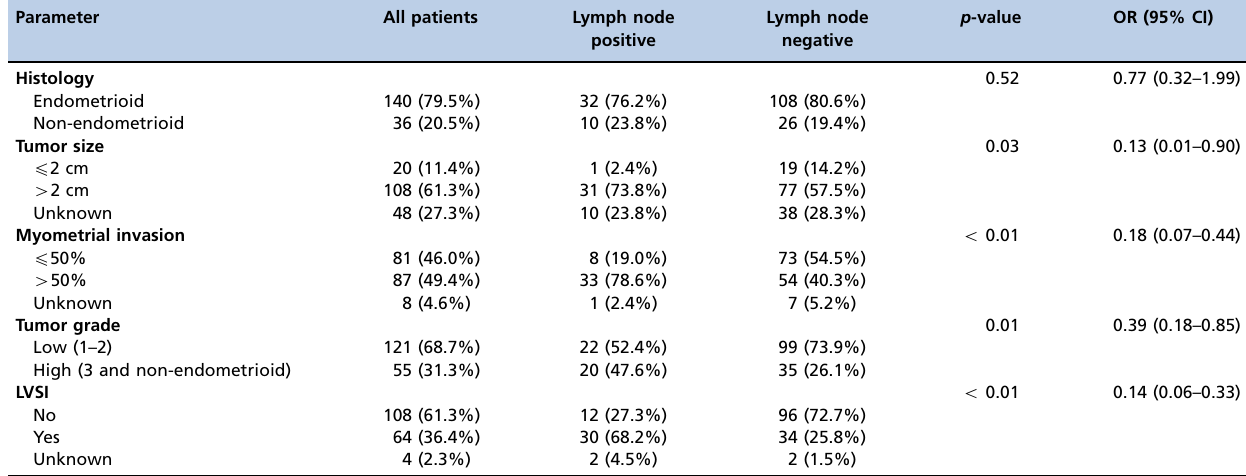
Table 2 - Tumor parameters according to lymph node status in 176 patients with surgically staged endometrial carcinoma. Parameter All